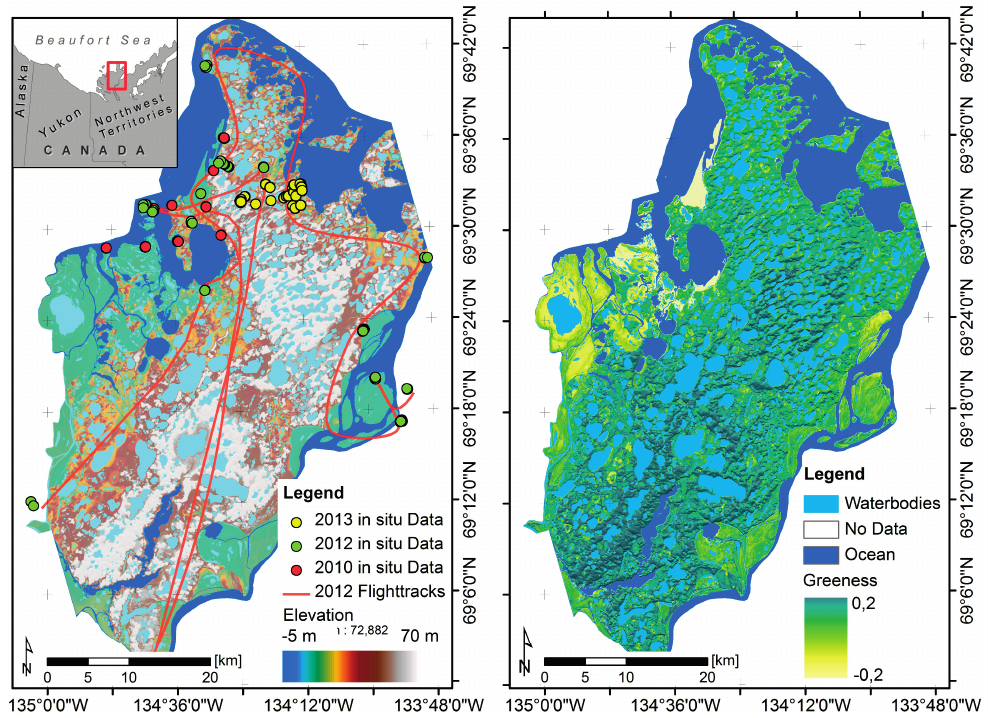
Figure 1. ( Left ) TanDEM-X digital elevation model 2012 and location of visited sites ( in situ data); ( Right ) and Landsat 8 Greenness 2013 of Richards Island, Northwest Territories,